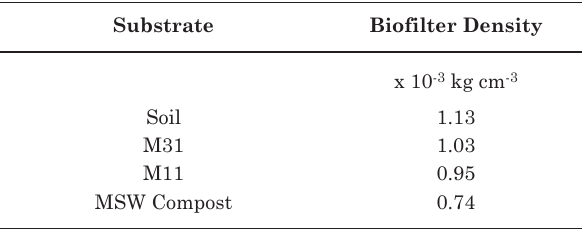
table 1. initial biofilter density